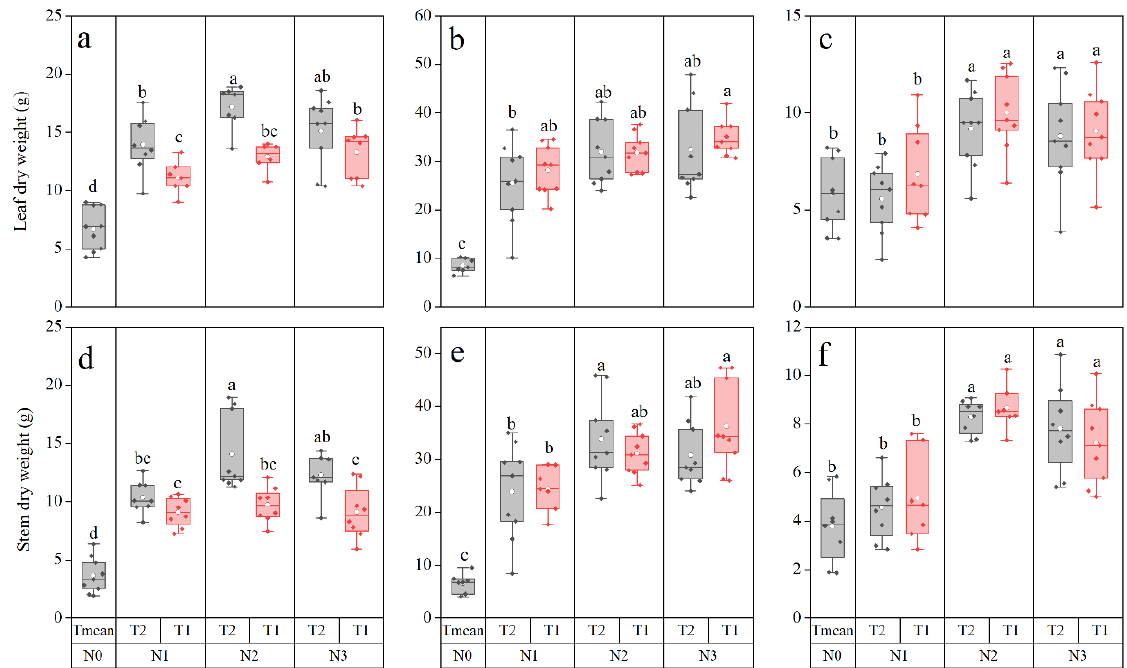
Figure 3. Stem dry weight and leaf dry weight of maize in 2018 ( a , d ), 2019 ( b , e ), and 2020 ( c , f ) in response to the rate and timing of N. Different letters indicate significant differences at p < 0.05.